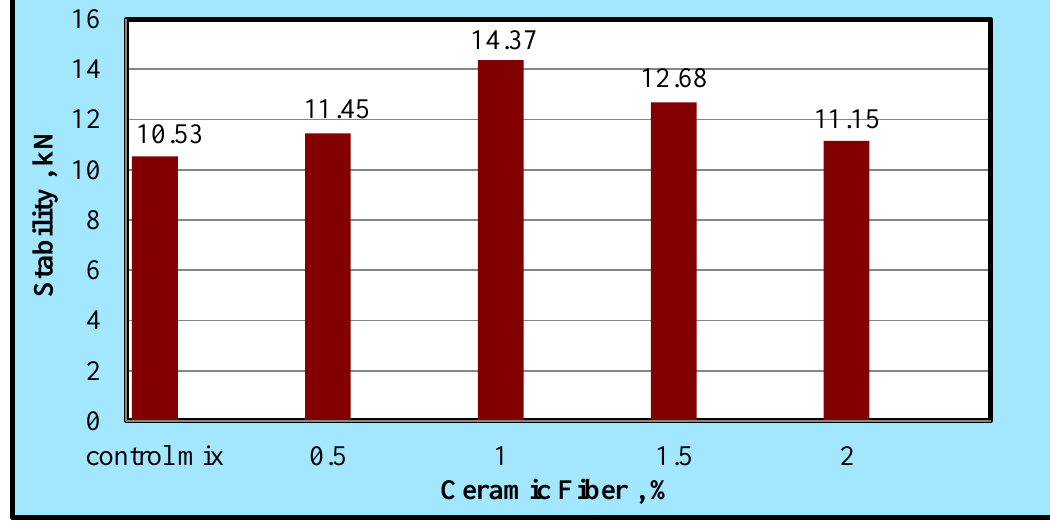
Fig. 1. Effect of Ceramic Fiber on Marshall Stability of Asphalt